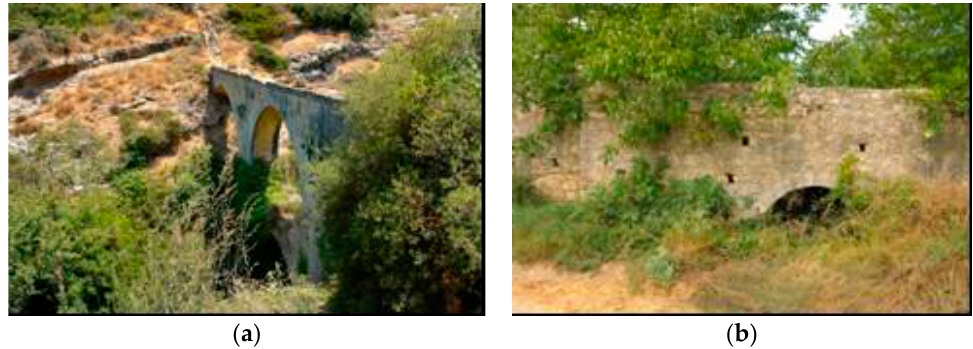
Figure 5. ( a ) Water bridge of Morosini’s aqueduct in Karidaki; and ( b ) one of its water bridges in the area of Agia Irini (with permission of A. N. Angelakis).